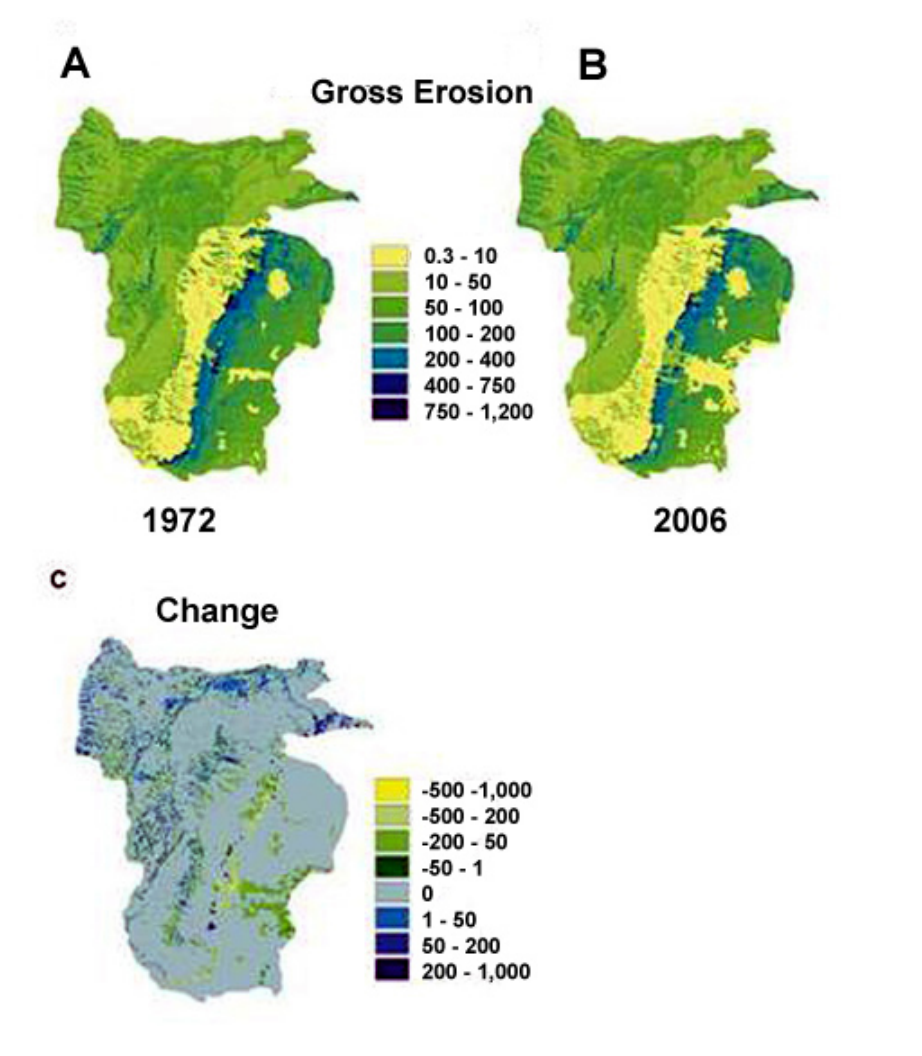
Fig. 3. Modeled gross erosion in 1972 (A), 2006 (B), and change between the two dates (C). All figures are in m 3 ha -1 year -1